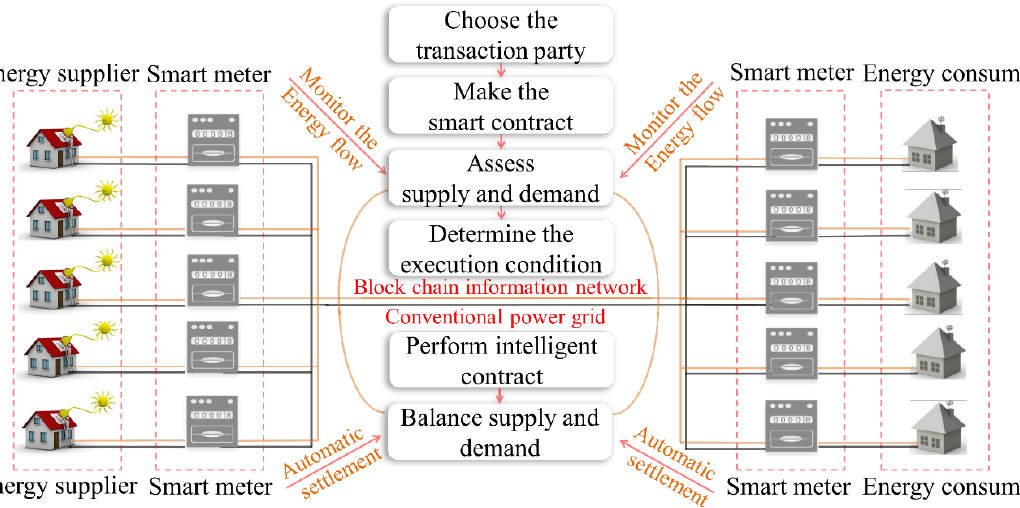
Figure 12. Demonstration of the blockchain technology in the energy market of a smart community.